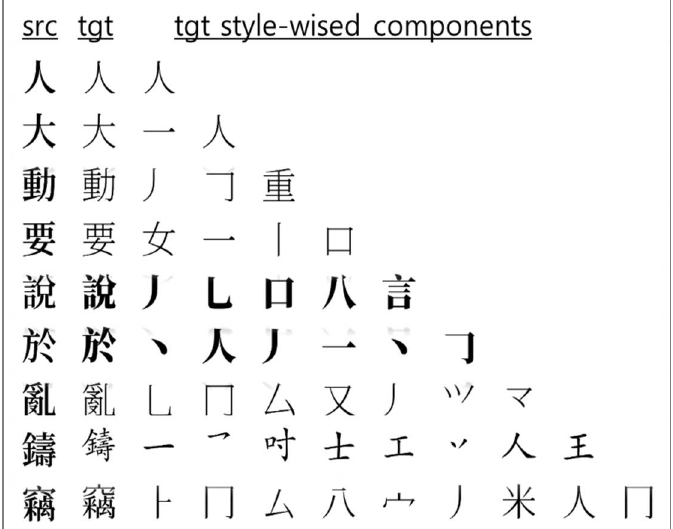
Figure 13. Input dataset sample by number of 1~9 components. Figure 14 shows the input representing a styled component for each font style for